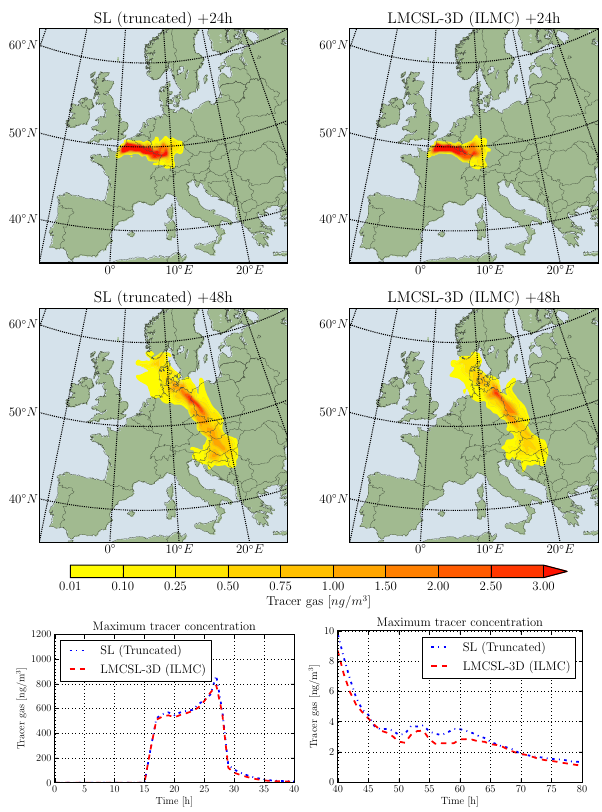
Fig. 7. Point source emission comparison using the ETEX-1 campaign. The top four panels show the truncated SL emission on the left and the LMCSL-3D with ILMC filter on the right. The lower panels show the maximum concentration during the simulations, with the dot-dashed (blue) line being the traditional non-conserving SL scheme and the dashed (red) line is the LMCSL-3D scheme with the ILMC filter.